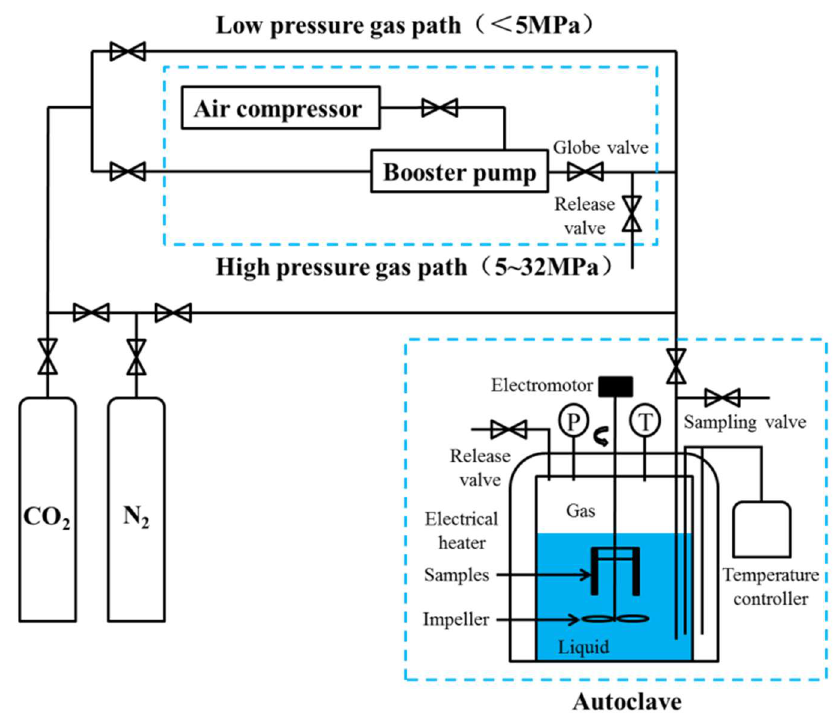
Figure 1. Flow chart of the evaluation system for steel corrosion rate (mass-loss method).